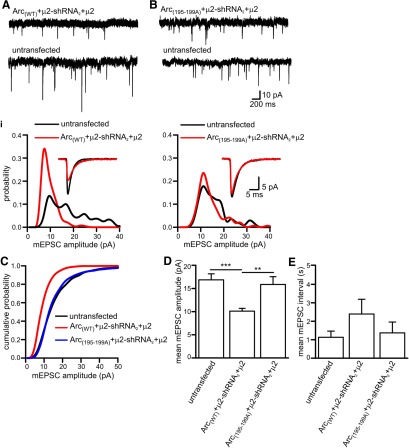
Arc–AP-2µ interaction is required for the Arc-mediated reduction in AMPAR mEPSC amplitude. A, Representative AMPAR-mediated mEPSC traces from a neuron expressing Arc(WT)+µ2-shRNA2+µ2 and an untransfected neighboring neuron. Ai, Amplitude probability distributions from the neurons showed in A. Note that reintroduction of µ2 rescued the effect of Arc(WT) overexpression leading to a reduction in the amplitude of mEPSC amplitudes (shift to the left, red trace). Inset, Superimposed average mEPSC waveforms. B, Representative AMPAR-mediated mEPSC traces from a neuron expressing Arc(195-199A)+µ2-shRNA2+µ2 and an untransfected neighboring neuron. Bi, Amplitude probability distributions from the neurons showed in D. Note that reintroduction of µ2 has little effect in mEPSC amplitude (no shifts between black and red traces). Inset, Superimposed average mEPSC waveforms. C, Cumulative probability distributions for cells expressing Arc(WT) +μ2-shRNA2 +μ2 (14 neurons), Arc(195-199A) +μ2-shRNA2 +μ2 (9 neurons), and untransfected cells (14 neurons). D, Bar chart plotting mean mEPSC amplitude for the cells in C. Expression of μ2 rescued the reduction in mEPSC amplitude produced by Arc(WT) overexpression, following the knockdown of AP-2 by shRNA2 (mean mEPSC amplitude in untransfected cells 16.9 ± 1.3 pA vs 10.1 ± 0.6 pA in cells expressing Arc(WT) +μ2-shRNA2 +μ2; p=0.0001). In contrast, expression of μ2 had no significant effect on mEPSC amplitude when Arc(195-199A), which does not interact with AP2, was expressed together with shRNA2 (15.9 ± 1.7 pA; p = 0.46). E, Bar chart plotting the mean interval between mEPSCs for the cells in C. The error bars in D and E are SEM. ***p<0.001, **p<0.01. Statistical significance was tested using the Mann–Whitney test.